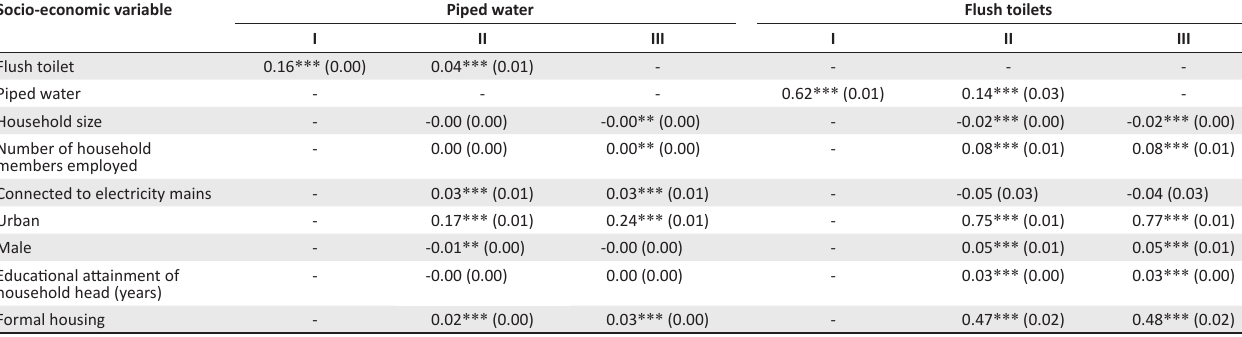
TABLE 3: Household socio-economic drivers of access to piped water and flushing toilet. Socio-economic